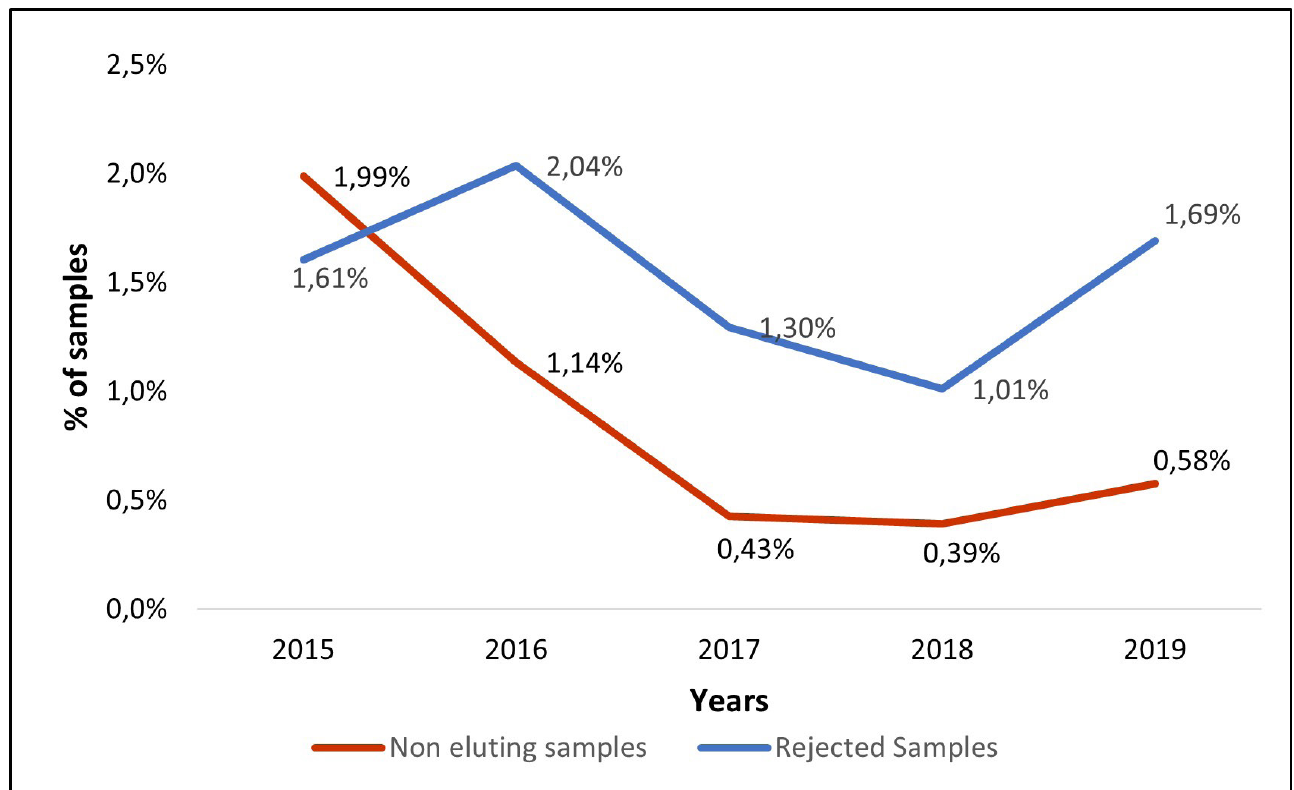
Figure 5. Non eluting and rejected samples, 2015 –